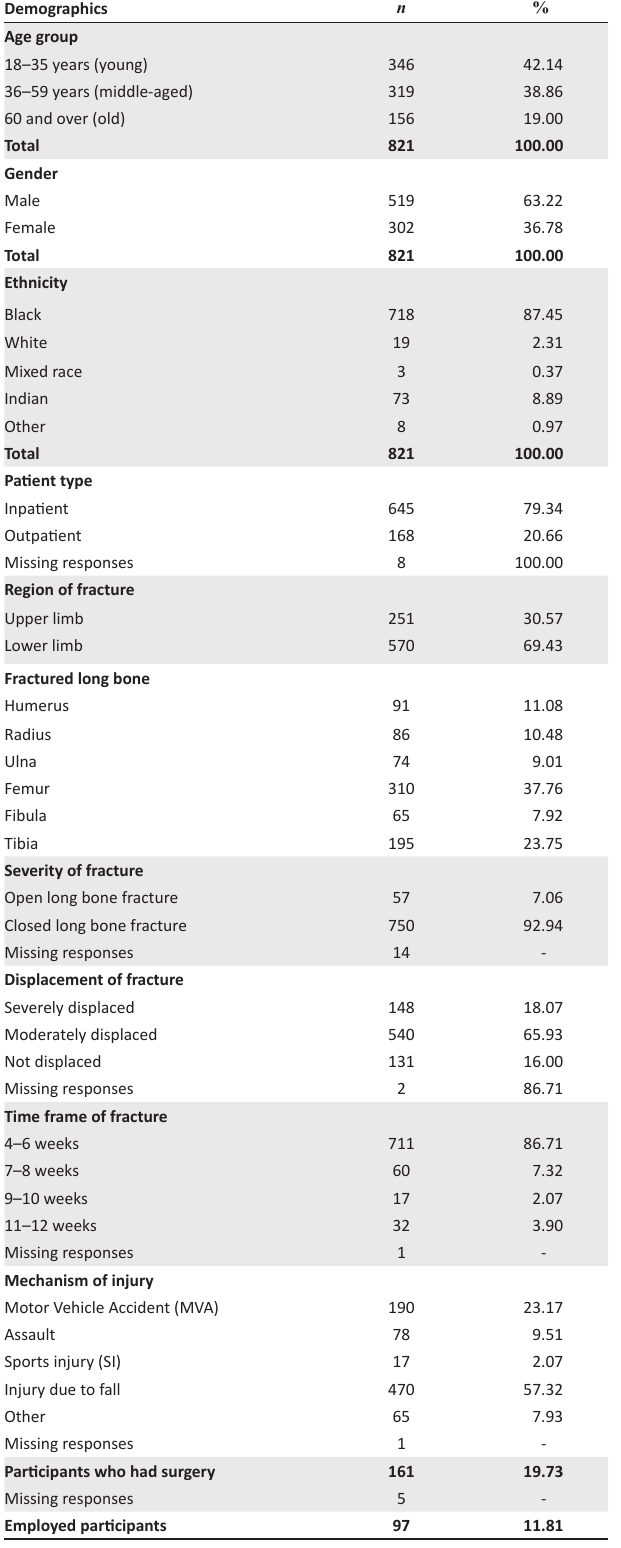
TABLE 1: Demographics and fracture characteristics ( n =